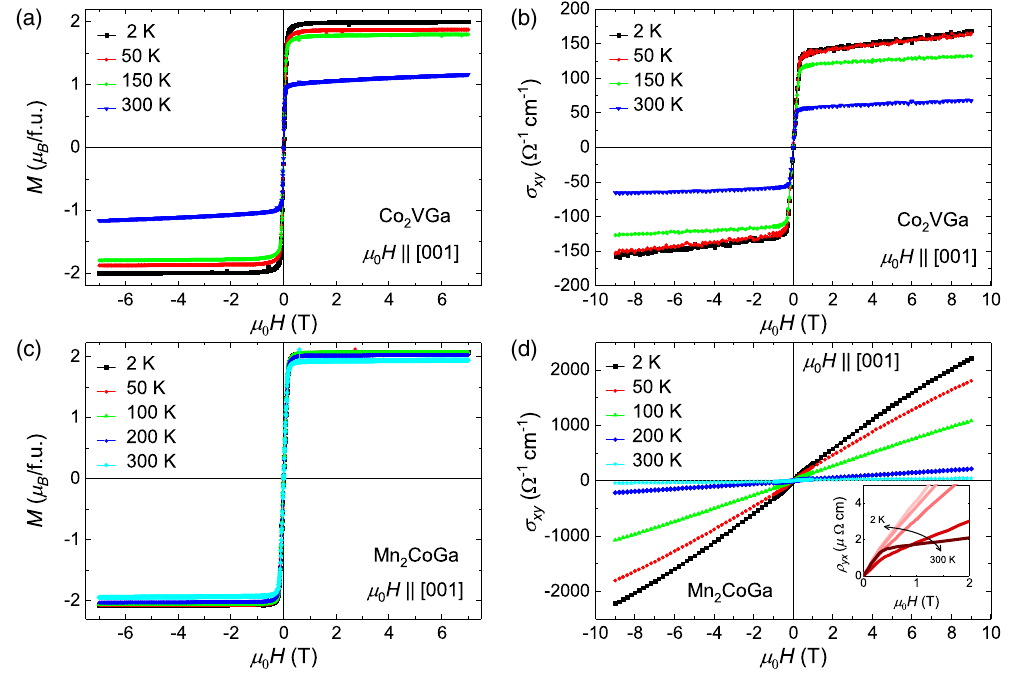
FIG. 3. (a),(c) Magnetic-field-dependent magnetization and (b),(d) corresponding field- and temperature-dependent AHC [ σ xy ] of (a),(b) Co 2 VGa and (c),(d) Mn 2 CoGa single crystals with field along the [001]. Inset of (d) shows a magnified view of the field-dependent Hall resistivity [ ρ yx ] of Mn 2 CoGa at various temperatures from 2 to 300 K in the low-field region. Here f.u. is formula